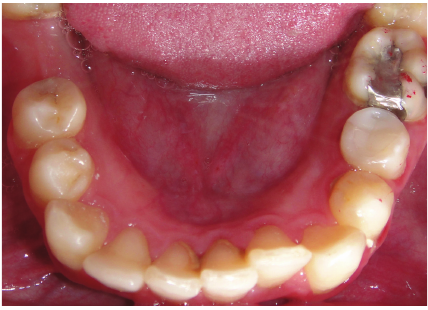
Figure 4: Clinical intraoral view of case after coronal restoration.